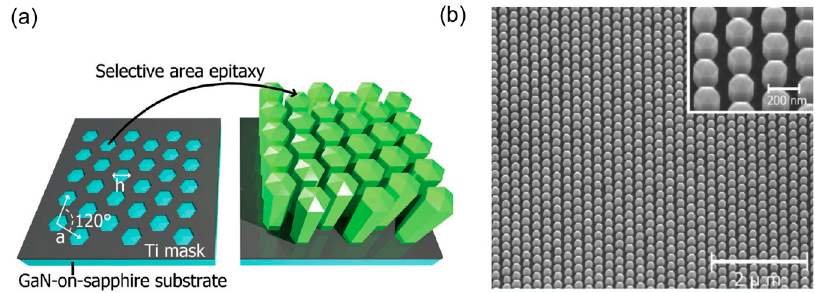
Figure 1. ( a ) Schematic of the selective area epitaxy process on Ti-patterned GaN template; ( b ) Scanning electron microscopy (SEM) image of GaN nanowires produced by selective area epitaxy [55].